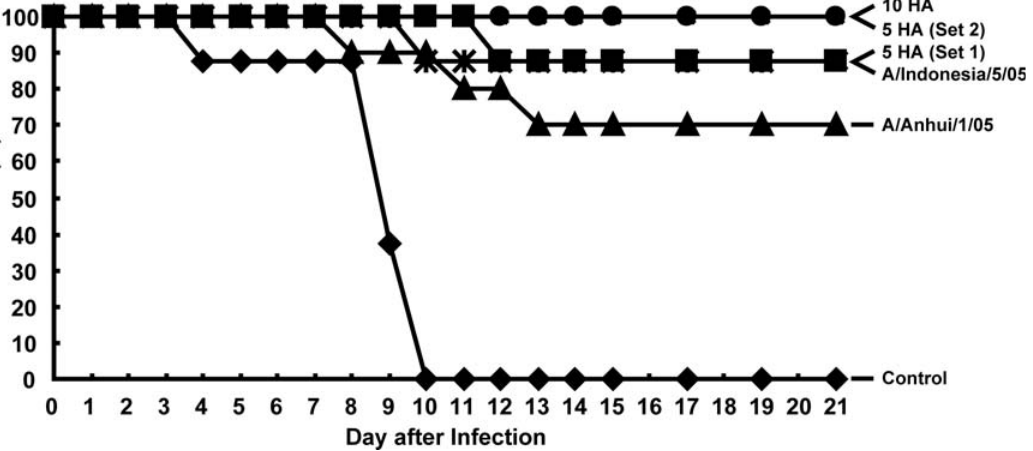
Figure 3. Immune protection conferred against lethal challenge of A/Vietnam/1203/2004 in mice 68 weeks after vaccination. Mice were immunized with 15 m g total of either the 10 HA as in Fig. 2A, legend and Materials and Methods, 5 HA (Set 1) as in Fig. 2B, legend and Materials and Methods, 5 HA (Set 2) as mentioned in Fig. 2C, legend and Materials and Methods, monovalent A/Indonesia/05/2005 HA, monovalent A/Anhui/1/ 2005 HA, or Control (empty vector) three times at three week intervals as described in Fig. 2, legend. Animals (n=8–10 per group) were challenged 68 weeks later by intranasal inoculation. All control mice died 10 days after infection.